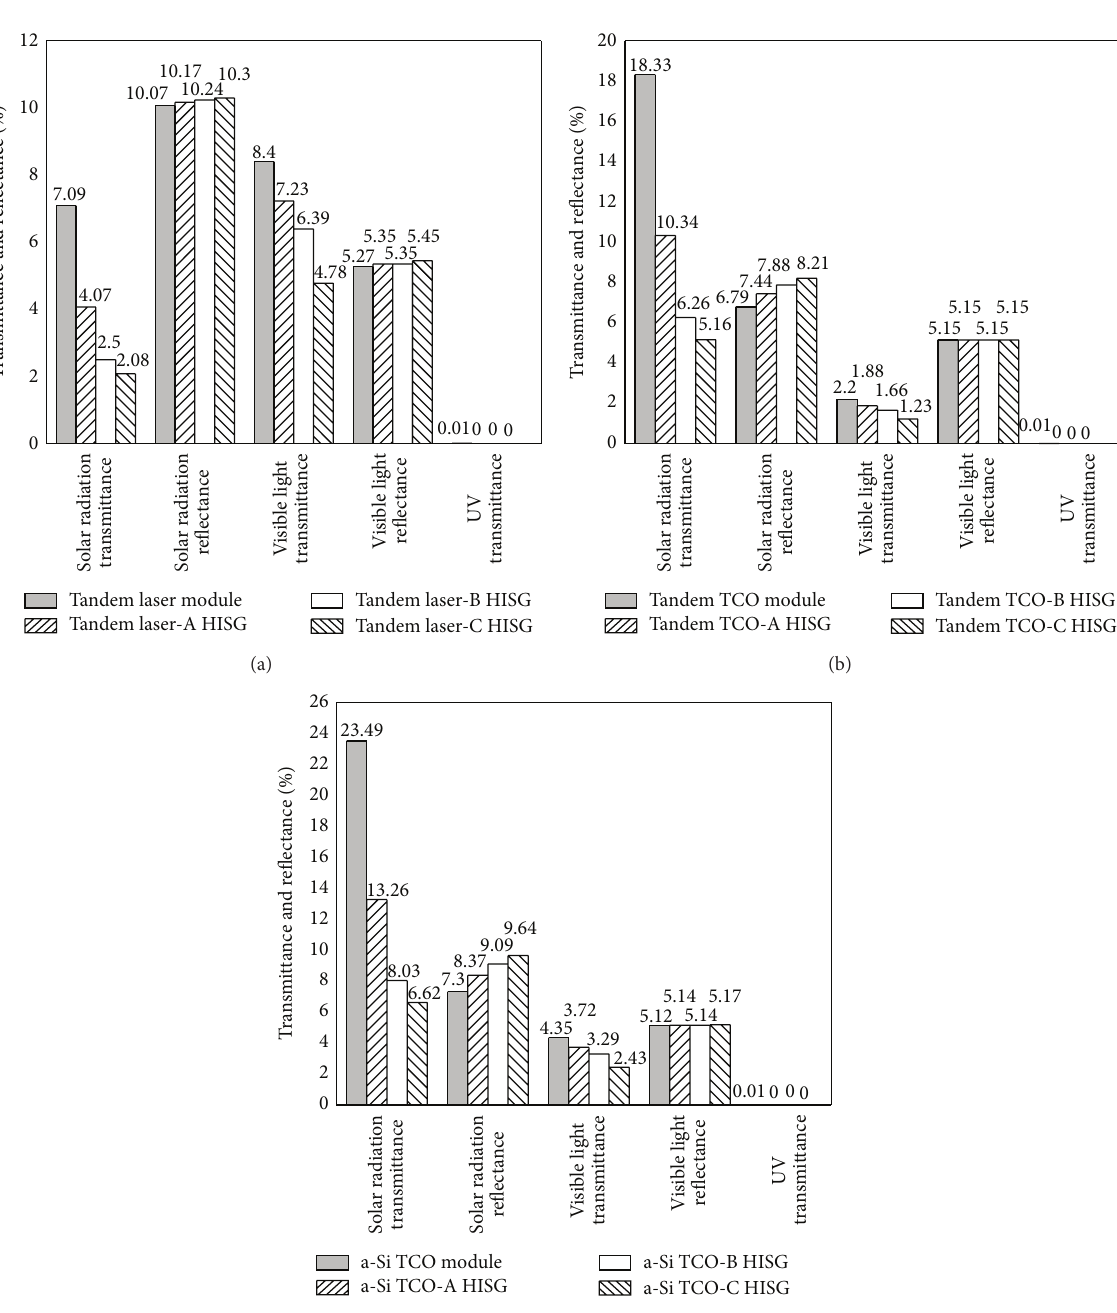
passing through the semitransparent PV modules. In